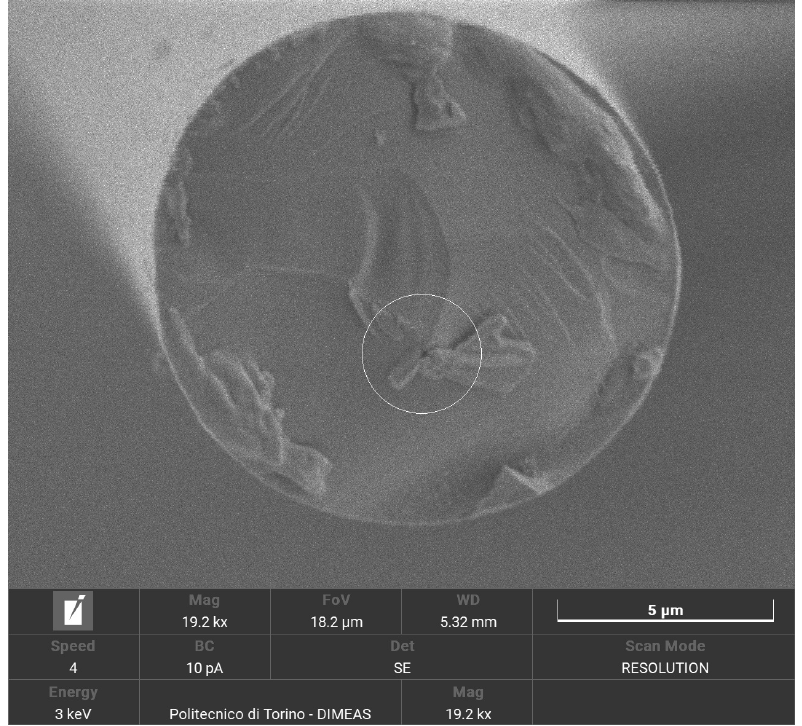
Figure 15. Fracture of recycled basalt single fiber nucleated from the bulk: the small circle indicates the nucleation